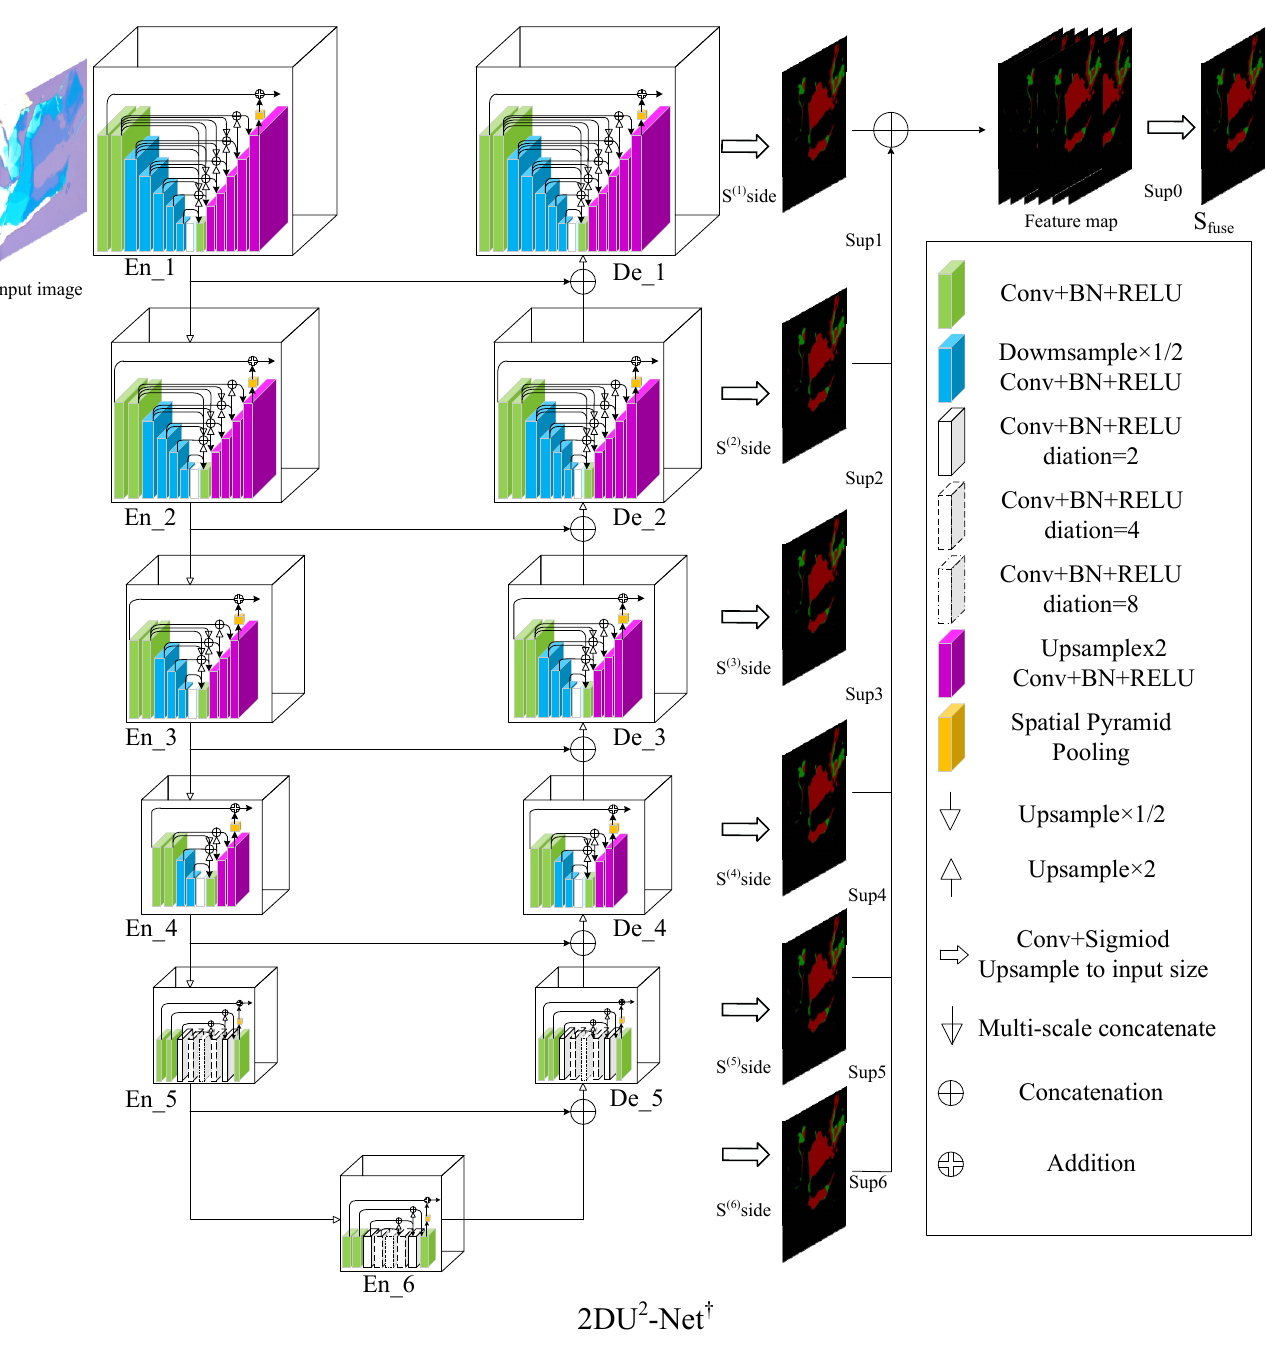
Figure 5. 2DU 2 -Net † model Figure 5. 2DU 2 ‐ Net † model structure.